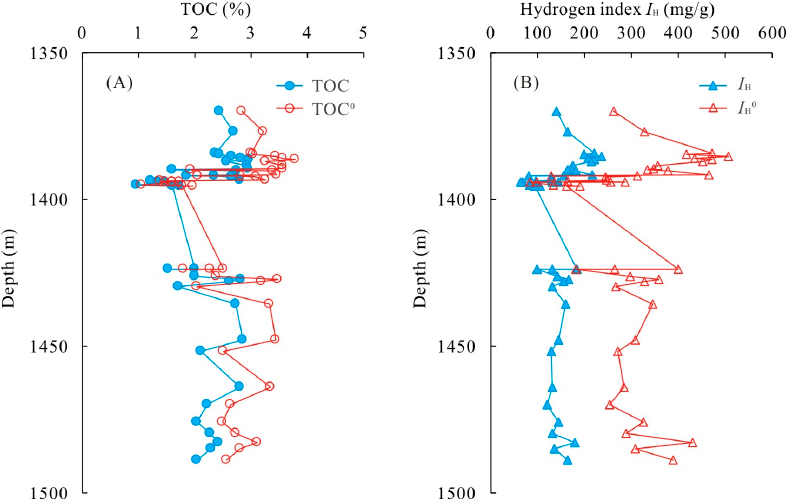
Figure 7. The original TOC and I H of K 1 yc 4 from well S59 in the South Shuangcheng Fault Depression: ( A ) TOC and original TOC; ( B ) I H and original I H .